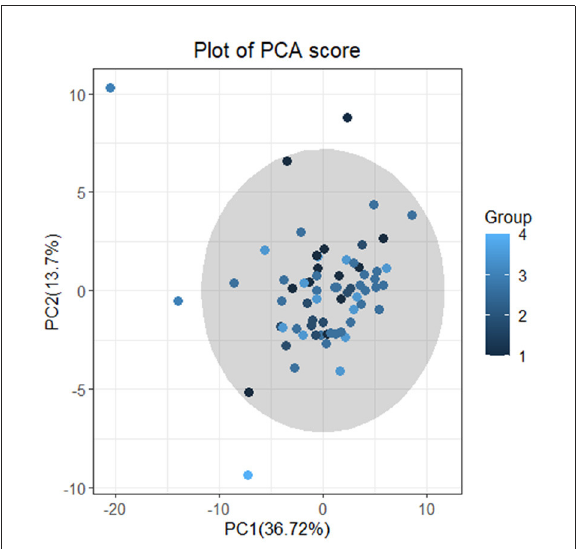
FIGURE3 Plot of PCA score. Principal component analysis (PCA). The four groups: group 1 = normal rotator cuff with normal clinical routine serum lipid test results; group 2 = normal rotator cuff with abnormal clinical routine serum lipid test results; group 3 = rotator cuff tear with normal routine serum lipid test results; group 4 = rotator cuff tear with abnormal routine serum lipid test results. Traditional abnormal clinical plasma lipid levels were defined as abnormal levels for at least two of four lipids (TG ≥ 1.70 mmol/L; TC ≥ 5.18 mmol/L; L-DLC ≥ 3.64 mmol/L; HDL-C ≤ 1.04 mmol/L). The results (PC1 = 36.72% < 50%;PC2 =